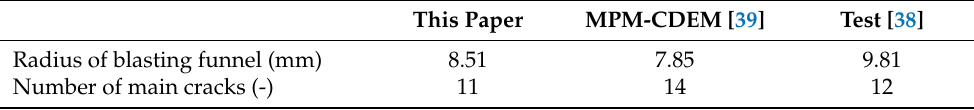
Figure 4. Cracking pattern of the single-hole blasting test. Table 3. The radius of the blasting funnel and number of main